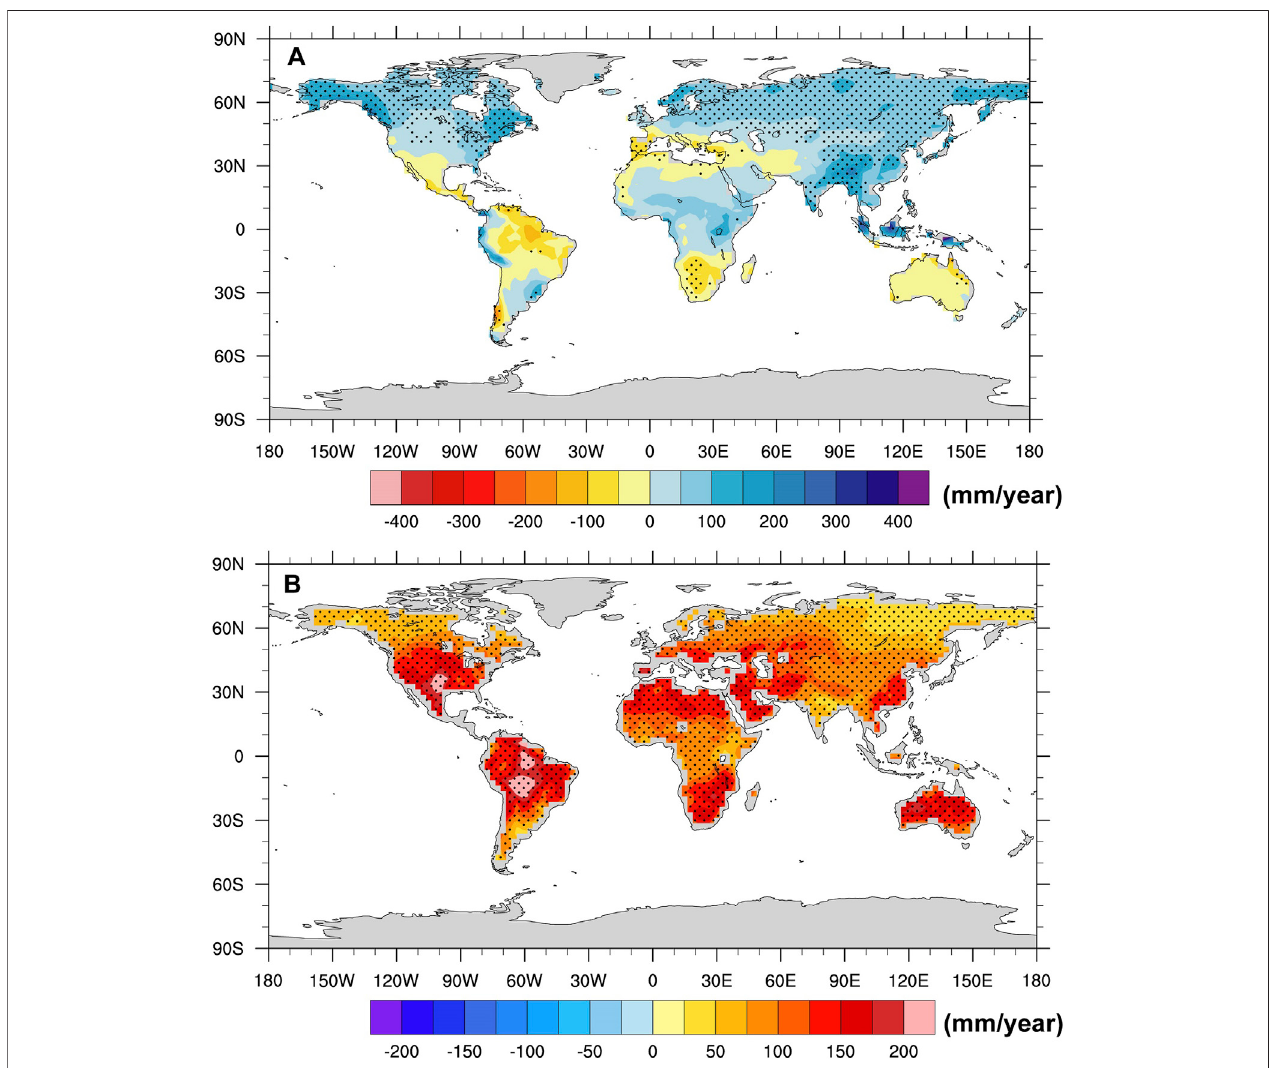
FIGURE 4 | Same as Figure 1A but for the changes in the mean (A) precipitation and (B) potential evapotranspiration.